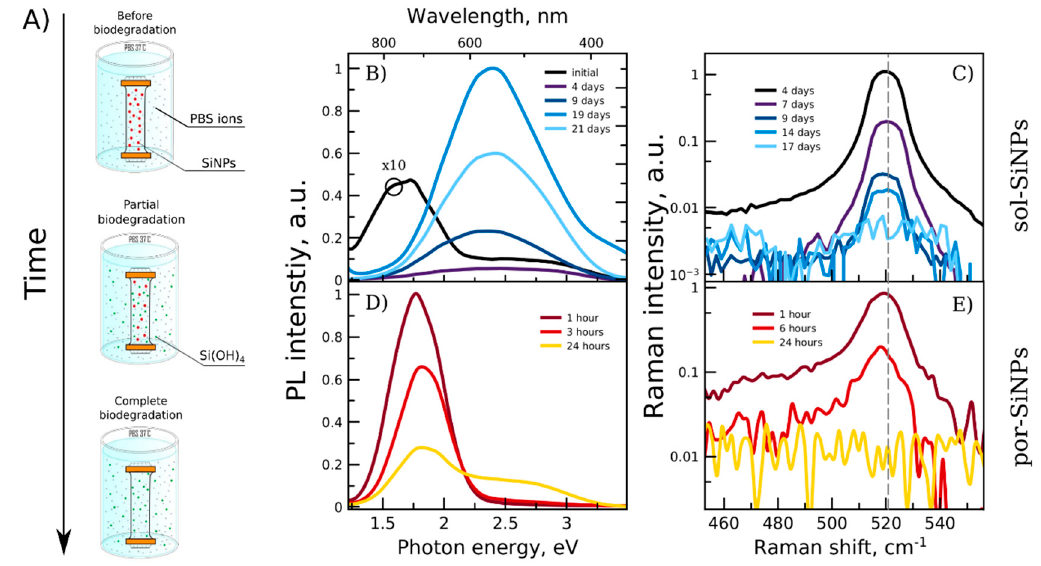
Figure 3. ( A ) Schematic view of dissolution of SiNPs in a dialysis bag from initial state (top) to completely dissolved (bottom). Red circles—SiNPs; green circles—silicic acid molecules, Si(OH) 4 ; gray circles—PBS ions. Photoluminescence ( B , D ) and Raman ( C , E ) spectra of sol-SiNPs ( B , C ) and por-SiNPs ( D , E ) during degradation in PBS (37 ◦ C). Legends show incubation time. Black PL curve for initial sol-SiNPs (plot B) was multiplied by a factor of 10. Vertical dashed gray line points to 520.5 cm − 1 corresponding to position of c-Si Raman